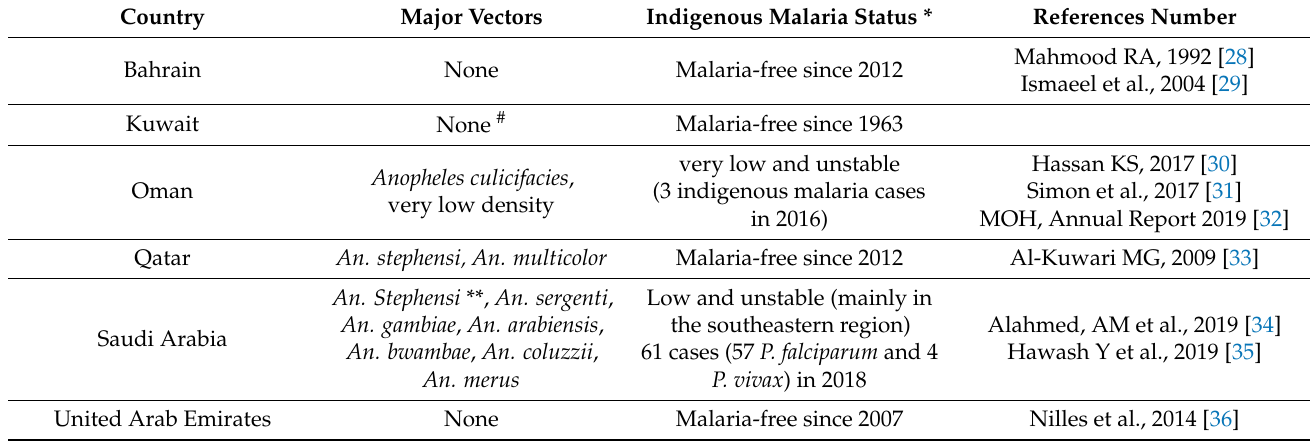
Table 1. An updated list of major malaria vectors and indigenous malaria status in GCC countries.